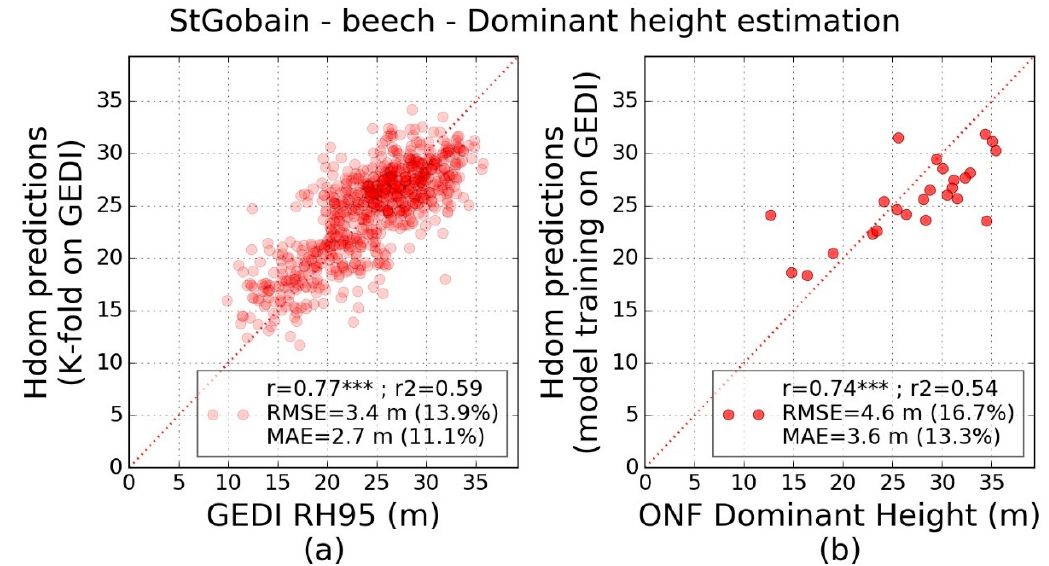
Figure 11. Beech samples (StGobain). Validation scatterplots of dominant height estimation using GEDI RH95% metric for the training model (723 samples). ( a ) GEDI’s K-fold cross-validation; ( b ) application of GEDI model on ONF measurement plots (25 samples). Statistical signicicance: *** p ≤ 0.001.